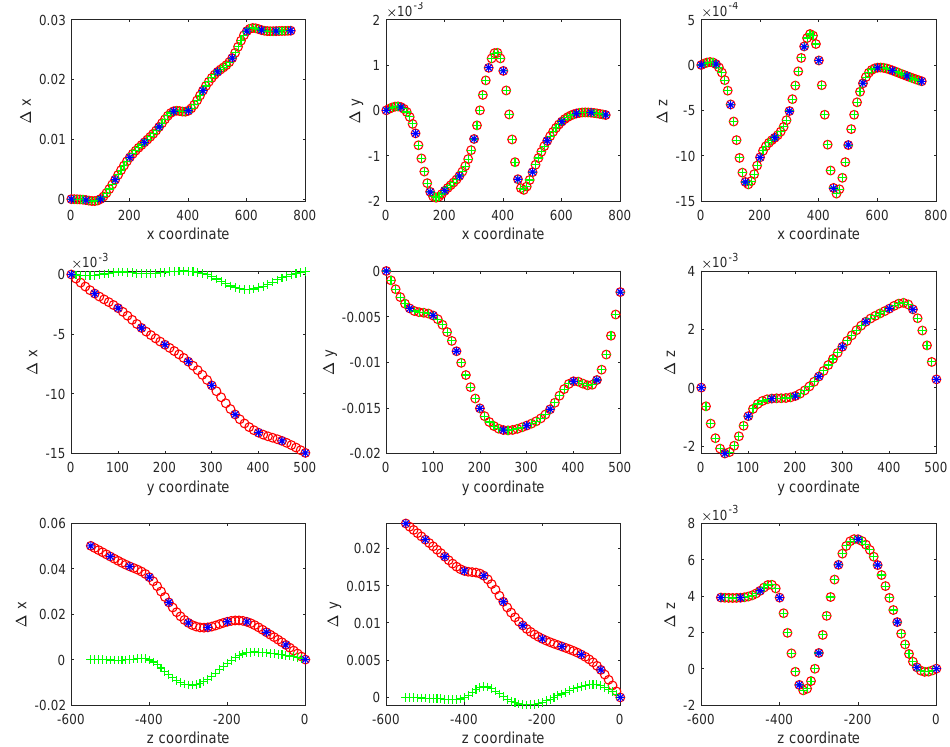
Figure 4. Difference between the calculated volumetric errors without evolution (green) and those with evolution (red) compared with the Trac-Cal data (blue). Units: